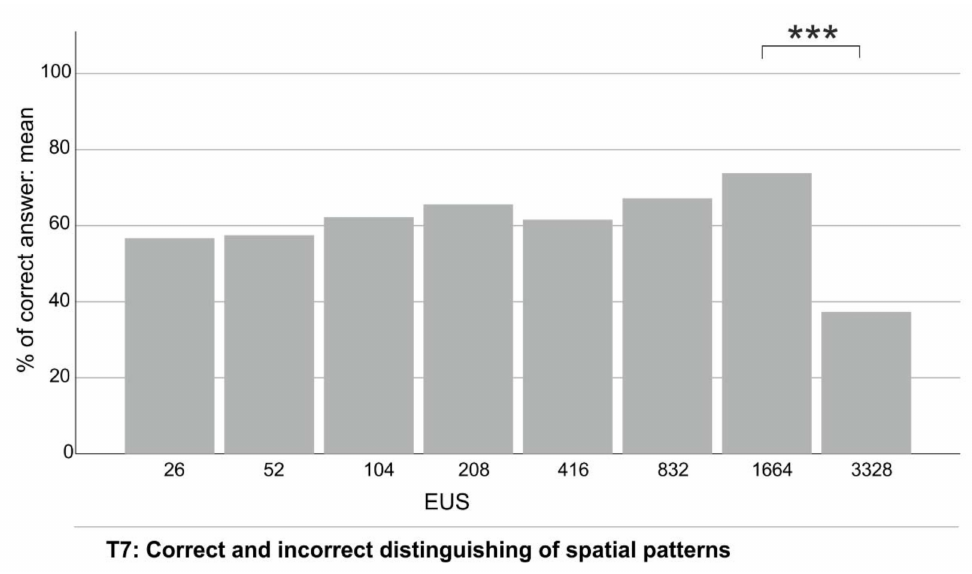
Figure 10. Participants’ answers concerning being able to distinguish correct and incorrect spatial patterns according to particular enumeration unit sizes, *** p ≤ 0.001. Table 4. The pairwise comparison of collected answers for task 7, *** p ≤ 0.001, ** p <